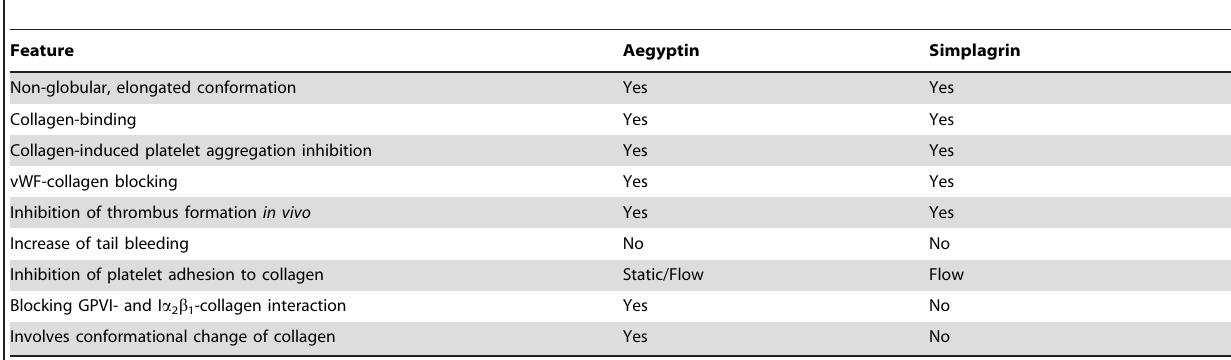
Table 5. Summarized comparison between Aegyptin and Simplagrin main features.